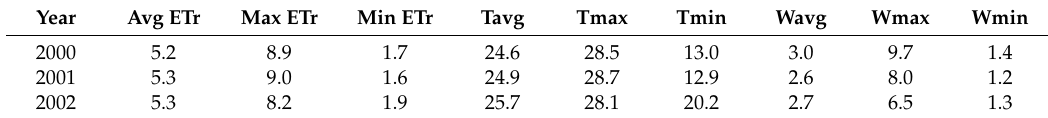
Table 2. Summary of reference ET (ETr), temperature and wind speed for the study